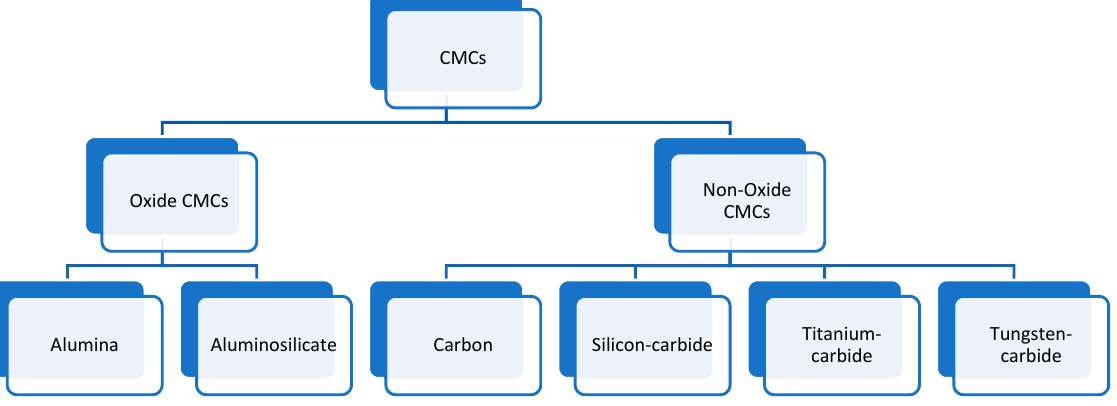
Figure 1. Oxide and non-oxide CMC material categories.